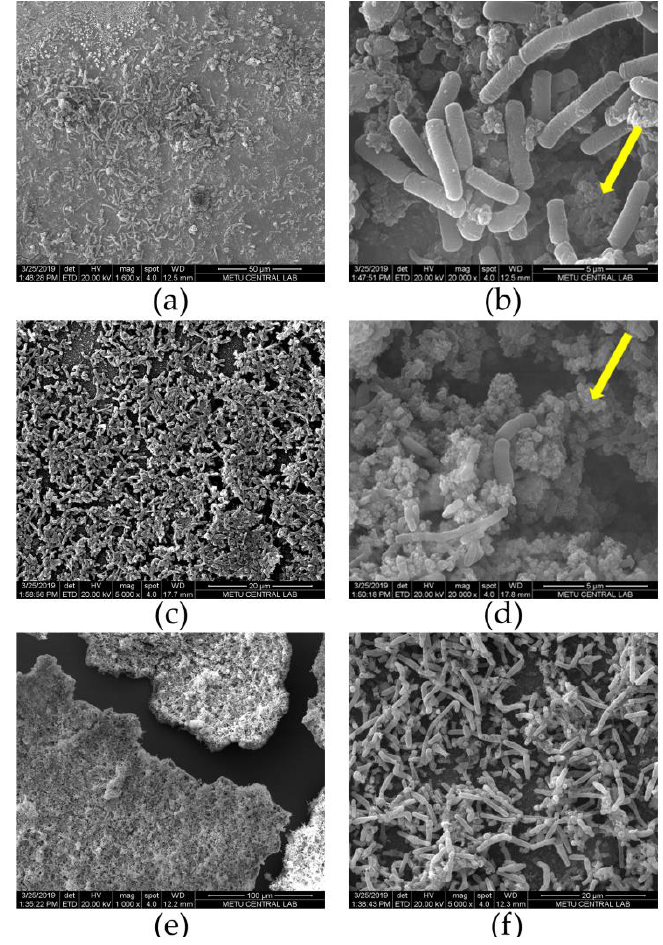
Figure 9. SEM images taken at 20 kV for different µMFC systems after the disassembly and fixation: ( a,b ) BG-25; ( c,d ) CYS-25; ( e,f ) MUA-OCV (arrows mark extracellular polymeric substances (EPS)).